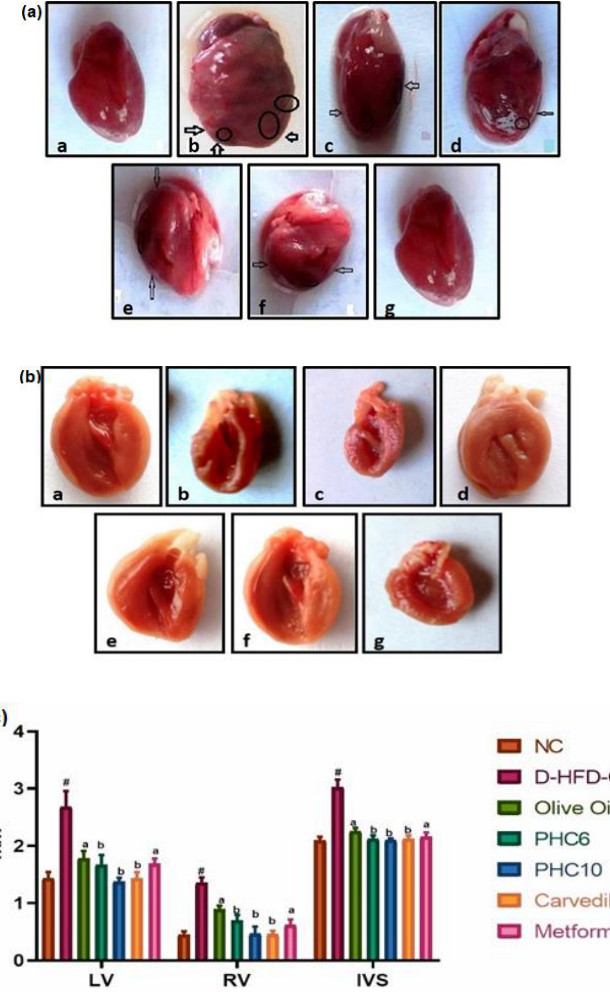
Figure 9. ( a ) Gross Morphology of intact heart from different treatment groups. ( b ) Gross Morphology of Heart section from different treatment groups. ( c ) Gross Morphology values of different treatment groups. All values are expressed as mean ± SD ( n = 6) analyzed by one-way ANOVA followed by Tukey’s t -test. D-HFD-C was compared with NC ( # p < 0.0001), and the values were found to be highly significantly different. The different treatment groups were compared with D-HFD-C, and the results for each parameter (LV, RV and IVS) were found to be different at the following significance levels: b p < 0.001; a p < 0.0001 from the respective disease control groups. NC is normal control; D-HFD-C is diabetic high-fat diet control group; PHC6 and PHC10 are polyherbal combination treated groups; LV is left ventricular wall thickness; RV is right ventricular wall thickness; IVS is intra-ventricular septum thickness). Table 5. Grading of Heart.